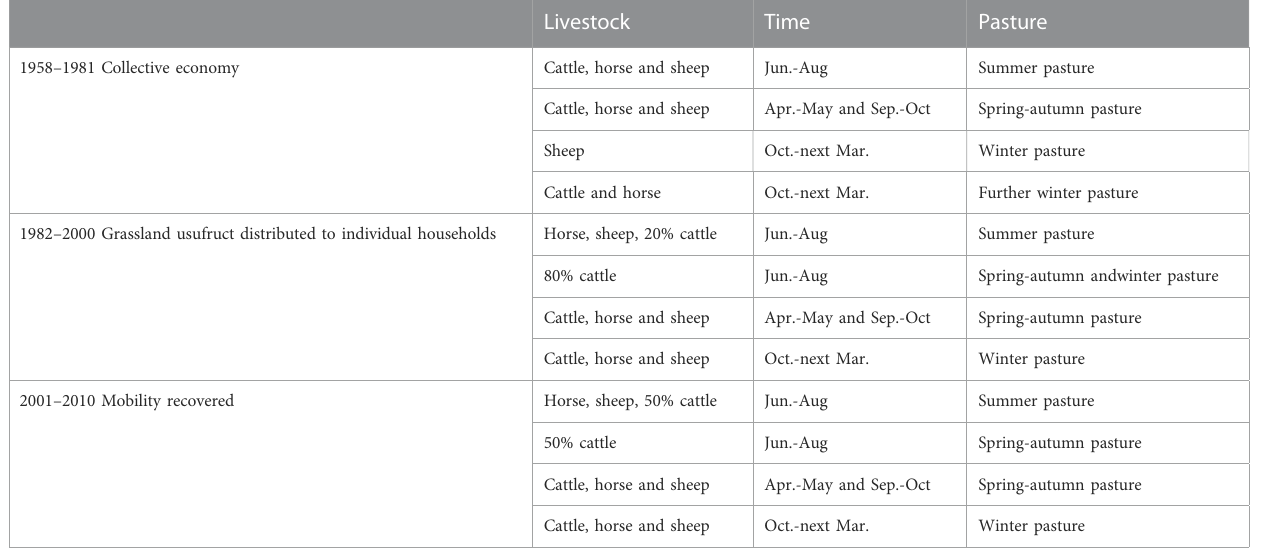
TABLE 4 Livestock mobility of GG Village in different